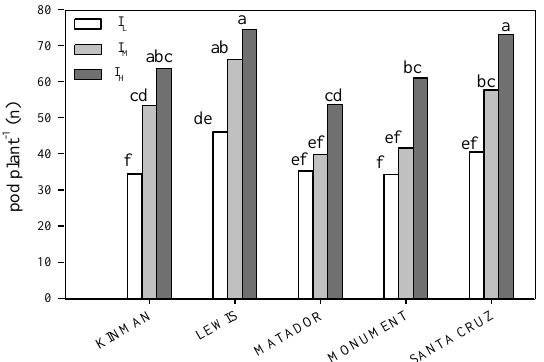
Figure 3. Two-year average number of pods per plant for each guar cultivar at three levels of irrigation.